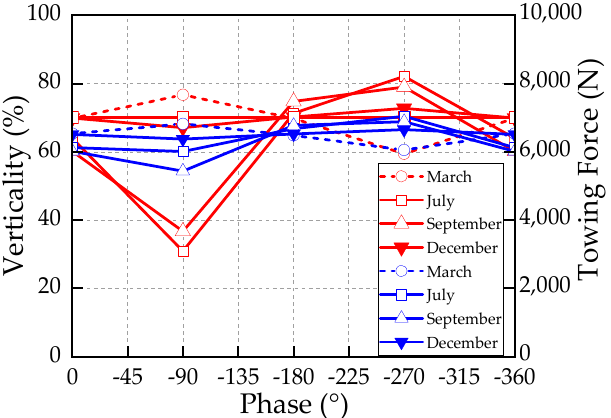
Figure 23. Relationship between verticality, towing force, and monthly average wind speed profiles (clockwise).